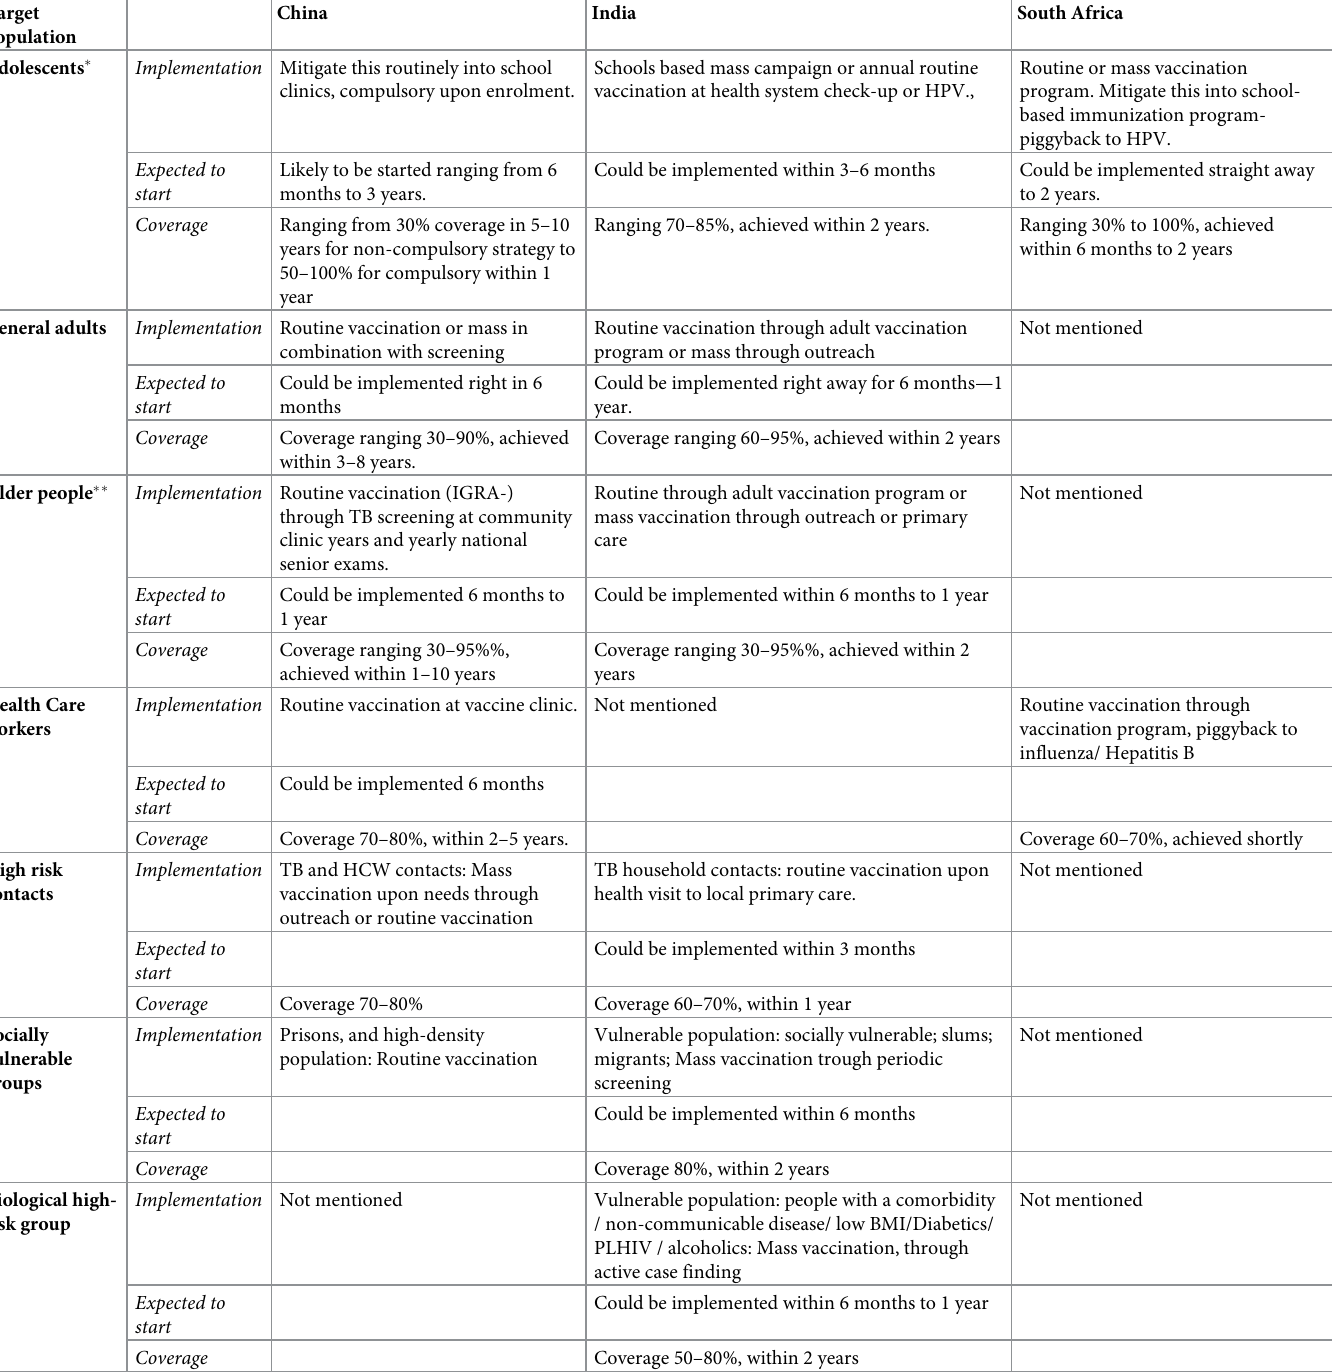
Table 3. Strategies to reach adult and adolescent populations with a BCG revaccination-like candidate. Target